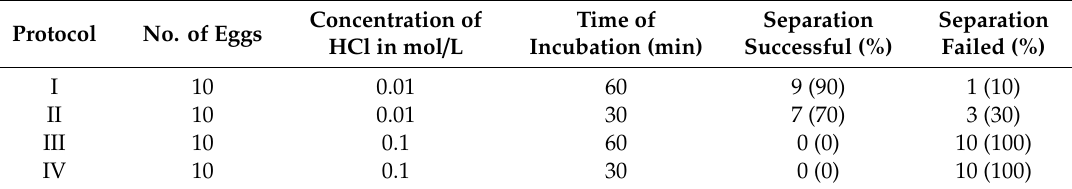
Table 2. IPVM isolation success in unfertilized chicken eggs influenced by separation protocol.